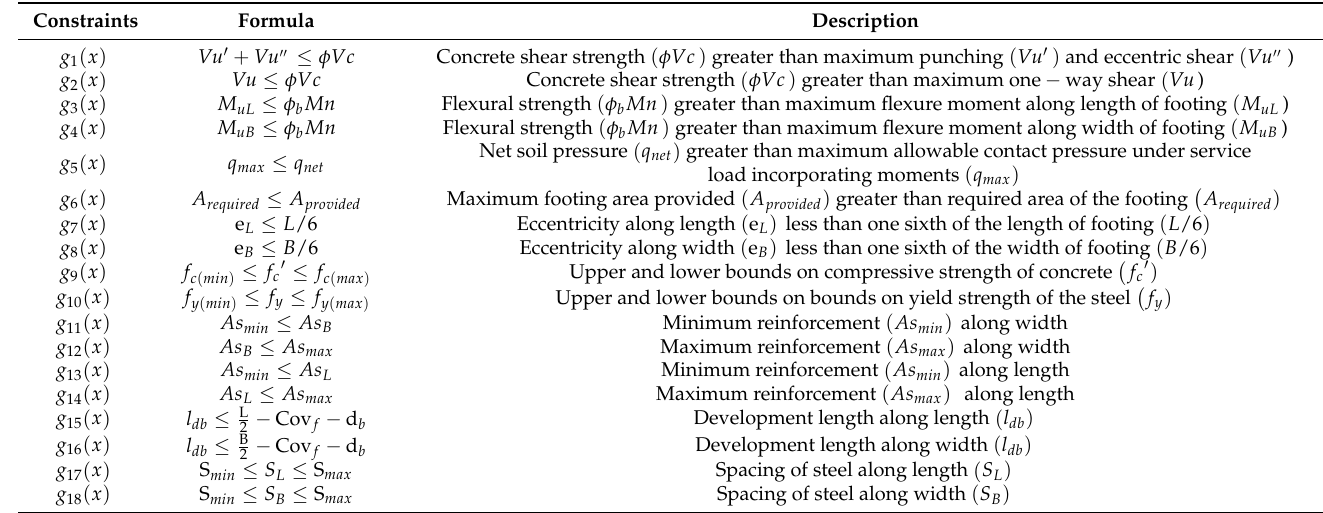
Table 2. Constraints used in